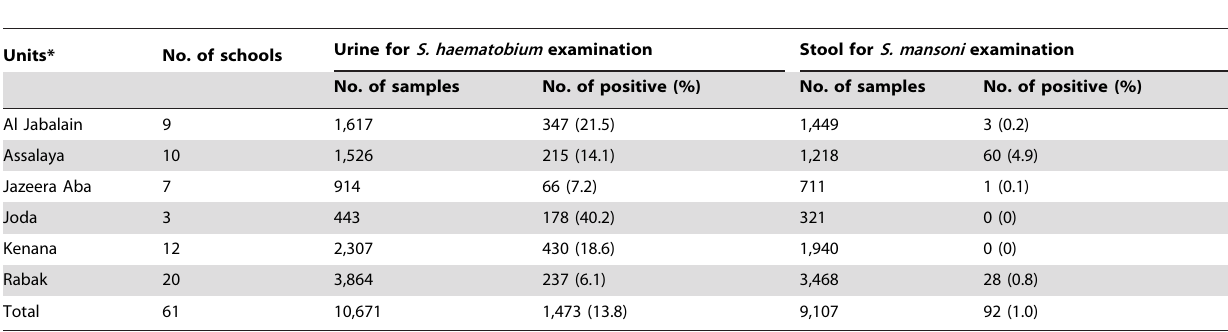
Table 2. The prevalences of S . haematobium and S. mansoni infection of primary school children at the baseline survey.